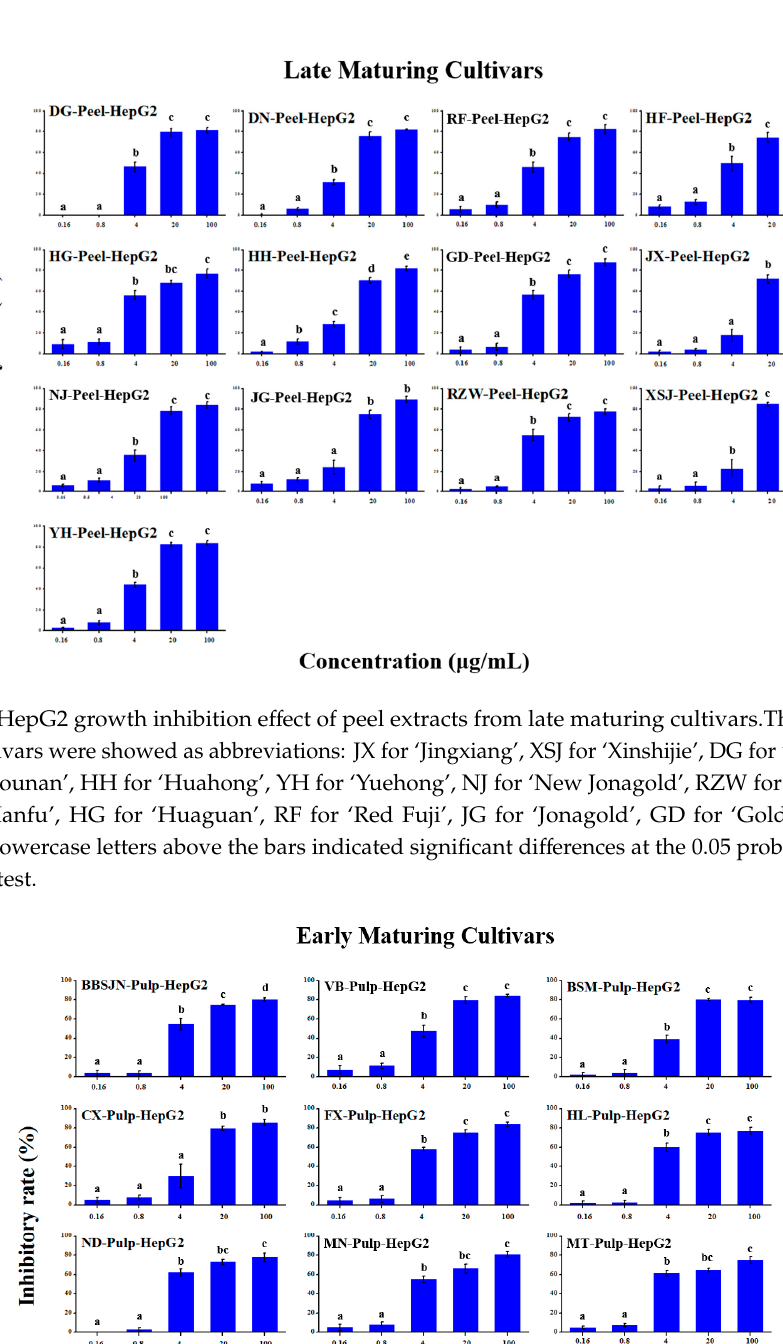
Figure 4. HepG2 growth inhibition effect of peel extracts from middle maturing cultivars.The names of apple cultivars were showed as abbreviations: PN for ‘Poland No.8’, SS for ‘Sourthern Snap’, QQ for ‘Qianqiu’, GL for ‘Gala’, HMT for ‘Hermhut’, XMF for ‘Ximengfei’, BTJQ for ‘ST’, YQ for ‘Yingqiu’, MTH for ‘Mantanghong’, QY for ‘Qiuying’. Different lowercase letters above the bars indicated significant differences at the 0.05 probability level by Tukey test.